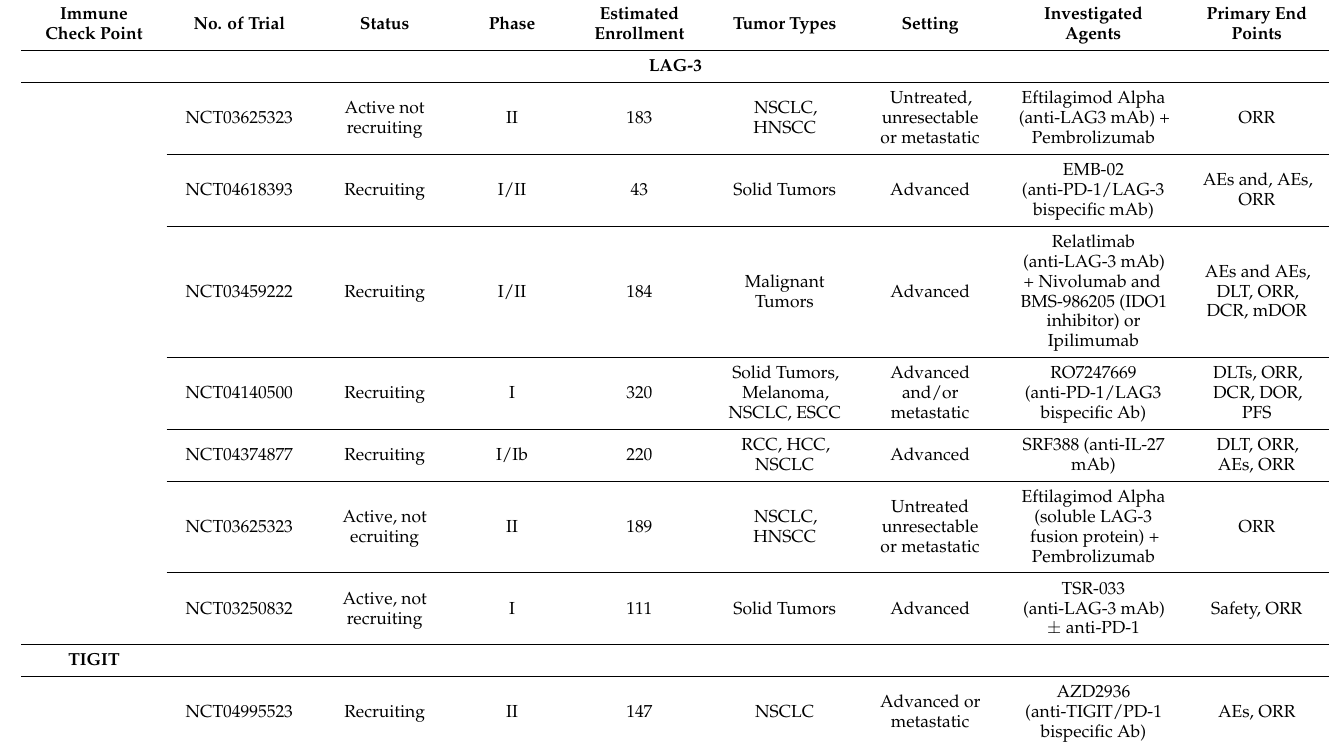
Table 2. Ongoing trial with new immune checkpoints targets in lung